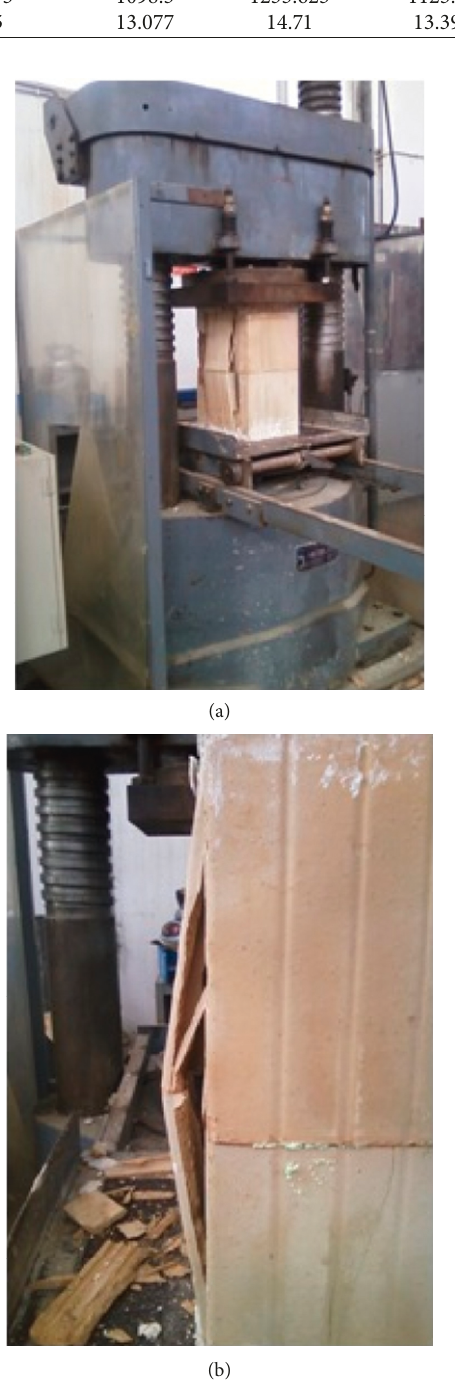
Figure 6: Details of the failure of the block in pure compression